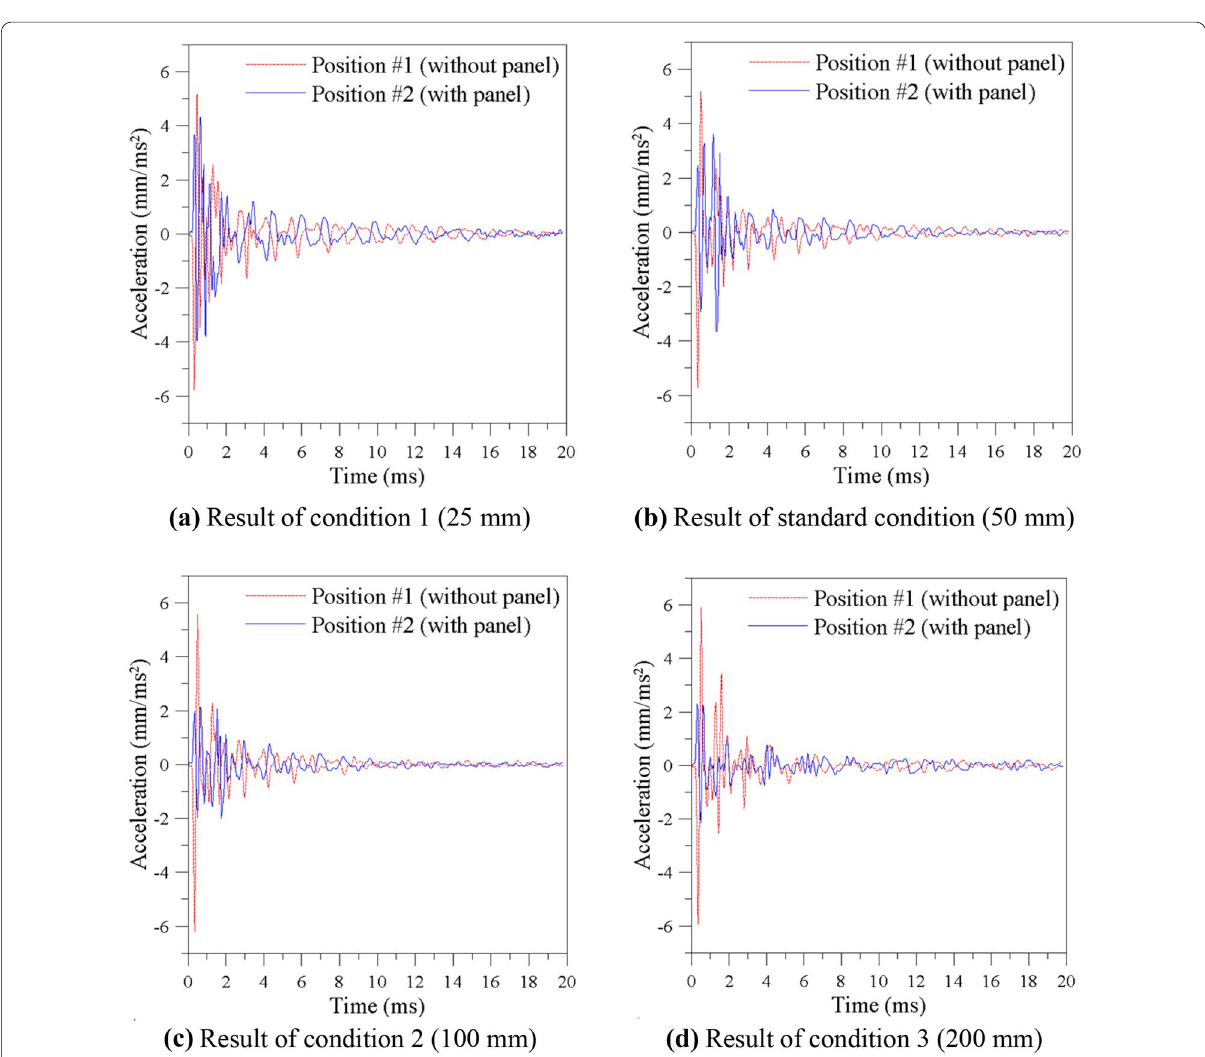
Fig. 18 Acceleration measured at outside wall according to blast‑proof panel thickness for high‑strength concrete.